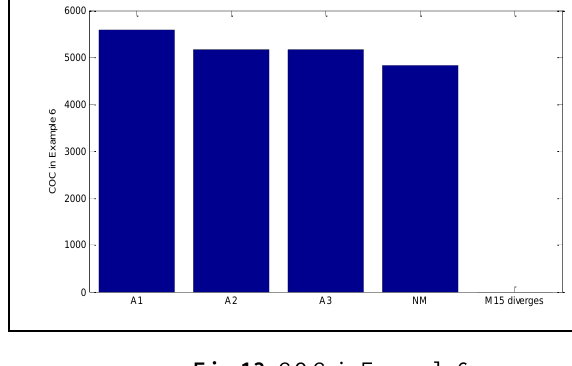
Fig. 9. Error drops for Example 6